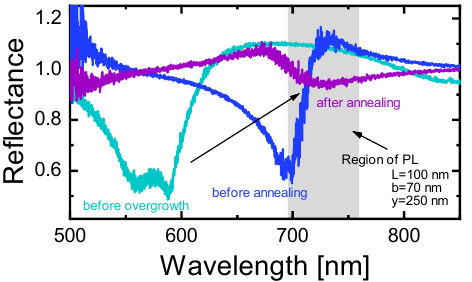
Figure 3. The resonance shifts to higher wavelengths after overgrowth and annealing. In the latter, the resonance is in the same range as the photoluminescence signal of the nanocrystals, so amplification can be expected after this fabrication